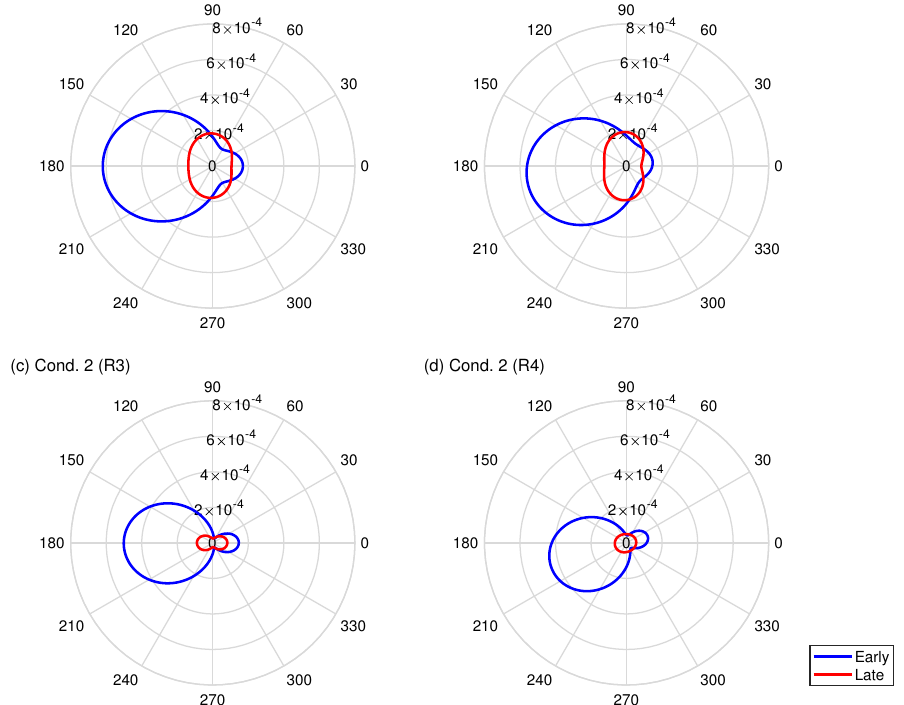
Figure 12. Directivity patterns in early and late times on a horizontal plane against azimuth φ with the following absorption and receiver conditions: ( a ) Cond. 1 and R3; ( b ) Cond. 1 and R4; ( c ) Cond. 2 and R3; and ( d ) Cond. 2 and